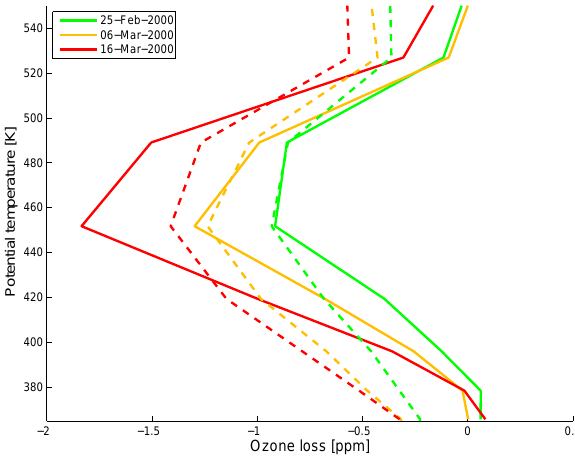
Fig. 3. Vortex-averaged ozone loss profiles for selected dates from measurements of ozone sondes treated by the vortex-average method (Rex et al., 2002, solid lines) and from the vortex-averaged results of the model (as in Fig. 2, but different vortex edge criterion, dashed lines). Results of the vortex-average method are convoluted to the altitude resolution of the model. The vortex edge criterion is identical to the one in Rex et al. (2002), both for model and mea- surements (40, 41, and 40 units of normalized PV,